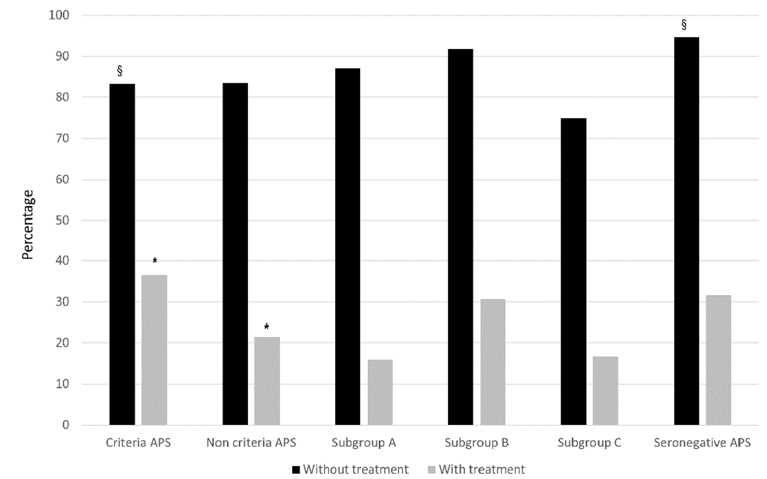
Figure 1. Pregnancy loss in the different groups according to treatment. Rates of patients with pregnancy loss (early pregnancy loss (<10 weeks) and/or fetal death (>10 weeks)) are expressed as percentages in the different groups according to standard (SoC) treatment. * Criteria APS vs. NC-APS: p = 0.023; § Criteria APS vs. SN-APS: p < 0.05.